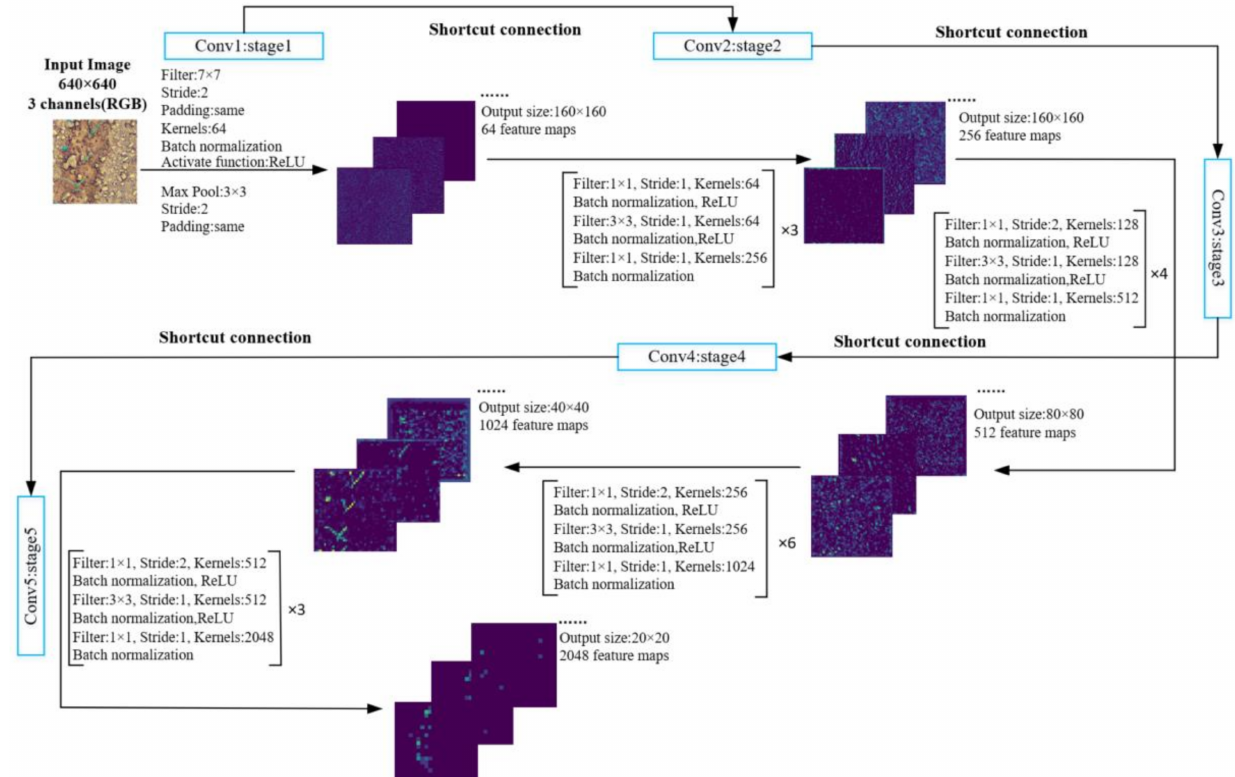
Figure 5. The structure of the ResNet50